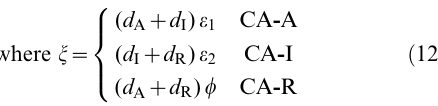
Figure S1 Distribution of the amount of reduction in cooperativity with positive feedback. The data in Figure 2 is revisualized (and kernel-smoothed) based on the amount by which positive feedback reduces cooperativity using the same color coding for the different motifs. Note that a positive value on the x- axis represents a reduction in the cooperativity by that amount. Figure S2 Relationship between the strength of positive feedback (measured by the parameter c ) and required degree of cooperativity. As the cooperativity is increased the system starts oscillating after undergoing a Hopf bifurcation. Thus, the Hopf bifurcation lines shown represent the boundary between non-oscillatory and oscillatory regimes. Small cooperativity and weak positive feedback never lead to oscillations. For 50 different random choices of degradation rates of the three components, the boundary between the two regimes for each of the positive feedback motifs in Figure 1B is shown. Notice how the boundary shifts to higher cooperativity at high positive feedback strengths for the MM and CA-R motifs.